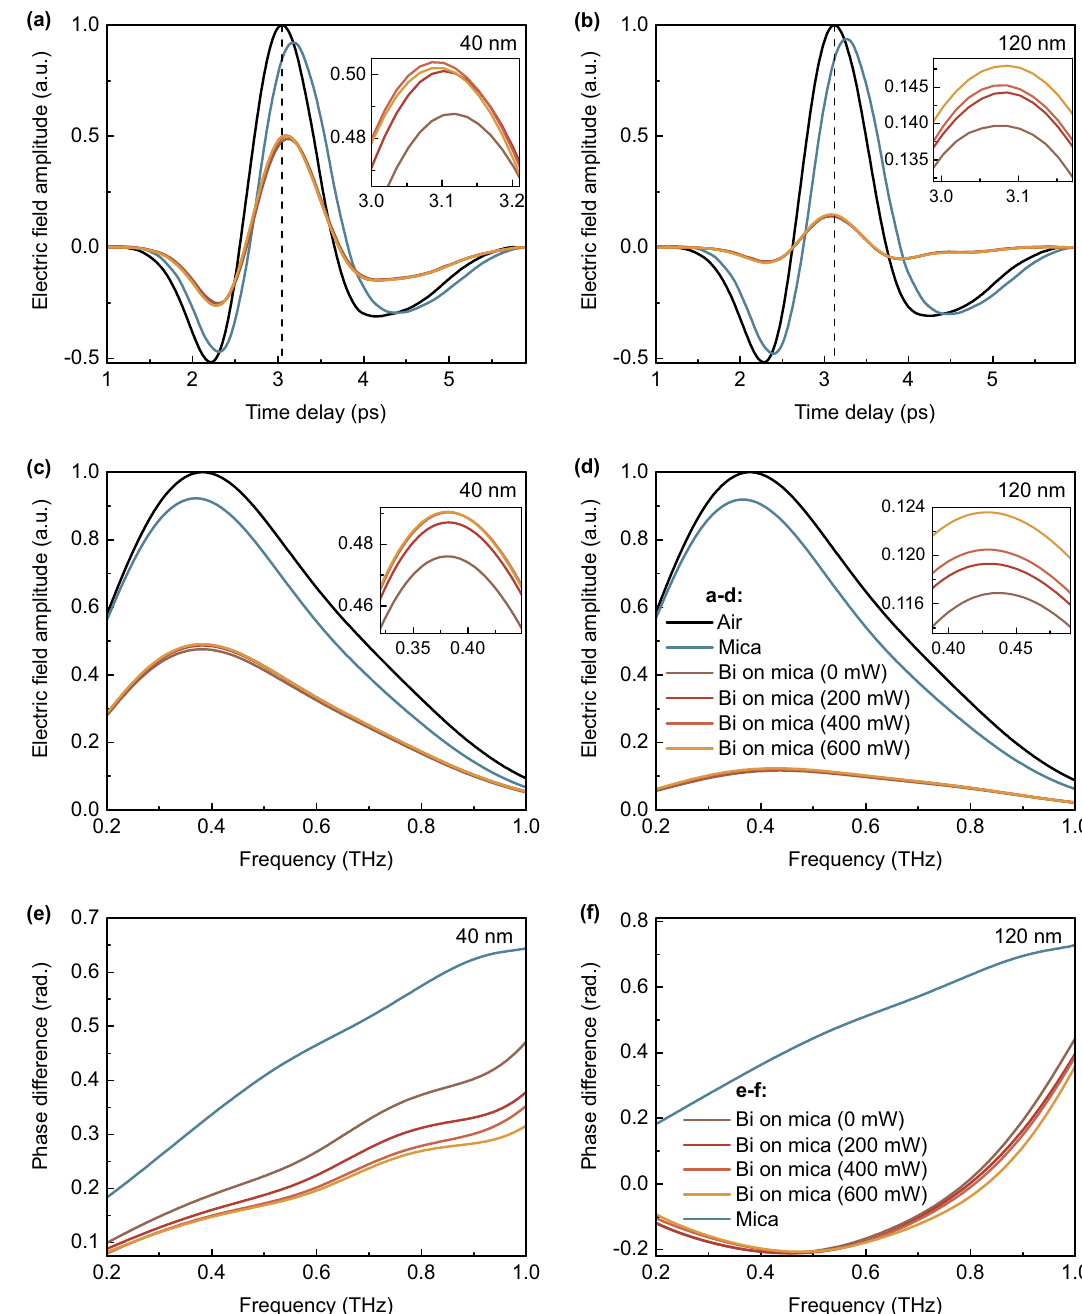
Figure 2. Results of experiment. Waveforms ( a,b ), amplitude ( c,d ) and phase difference ( e,f , in relation to air signal) spectra of THz pulse transmitted through the mica substrate and the whole Bi-on-mica structures (with Bi thickness of 40 ( a,c,e ) and 120 ( b,d,f ) nm) which are influenced by optical pumping with different